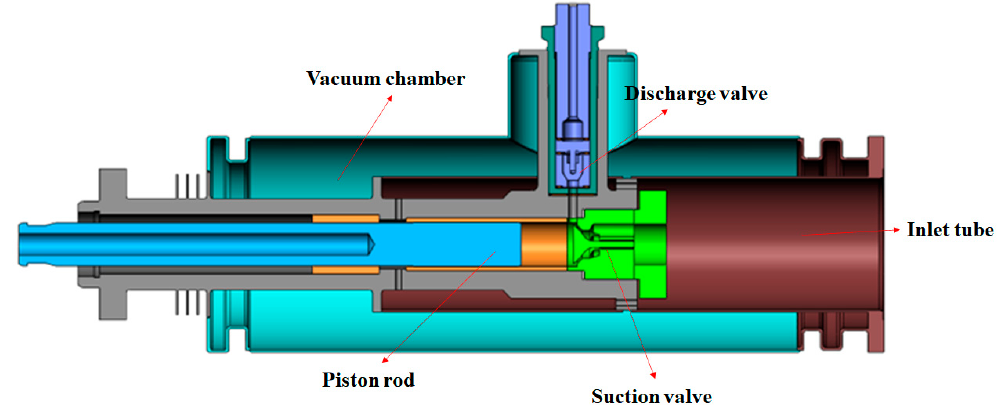
Figure 2. High-pressure liquid hydrogen reciprocating pump hydraulic end. PumpLinx includes an automated mesh generator that facilitates the generation of high-quality meshes that can be efficiently solved by CFD solvers. The mesh generator uses a proprietary geometry conformal adaptive binary tree (CAB) algorithm, which generates Cartesian meshes in a volume domain consisting of closed surfaces. Near geometric boundaries, CAB automatically adjusts the mesh to fit geometric surfaces and geometric boundary lines. To accommodate critical geometric features, CAB automatically resizes the mesh by continuously splitting the mesh, which is the most efficient way to resolve detailed features using the smallest mesh. The binomial tree Cartesian mesh has the advantages of fast generation, simple operation, better computational speed and accuracy than the tetrahedral mesh, and reduced geometric trimming effort. The created mesh is shown in Figure